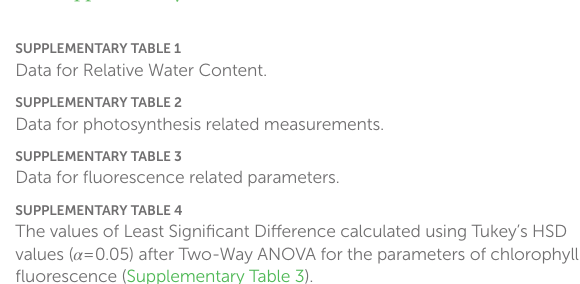
SUPPLEMENTARY TABLE 1 Data for Relative Water Content. SUPPLEMENTARY TABLE 2 Data for photosynthesis related measurements. SUPPLEMENTARY TABLE 3 Data for fluorescence related parameters.